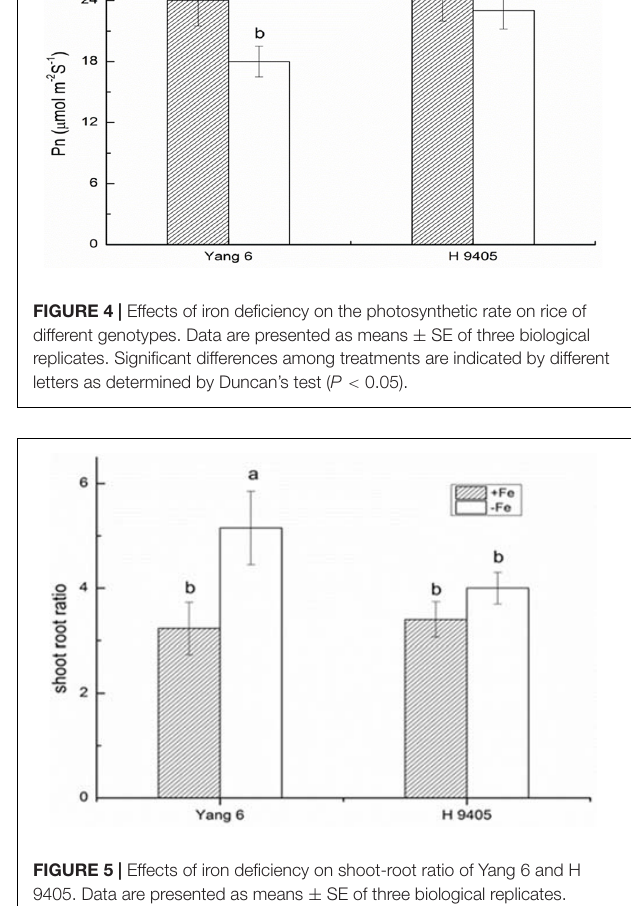
special attention was paid to rice growth status, photosynthetic characteristics, anti-oxidation systems, marker genes correlated with Fe uptake and transport and signal transduction in this study.